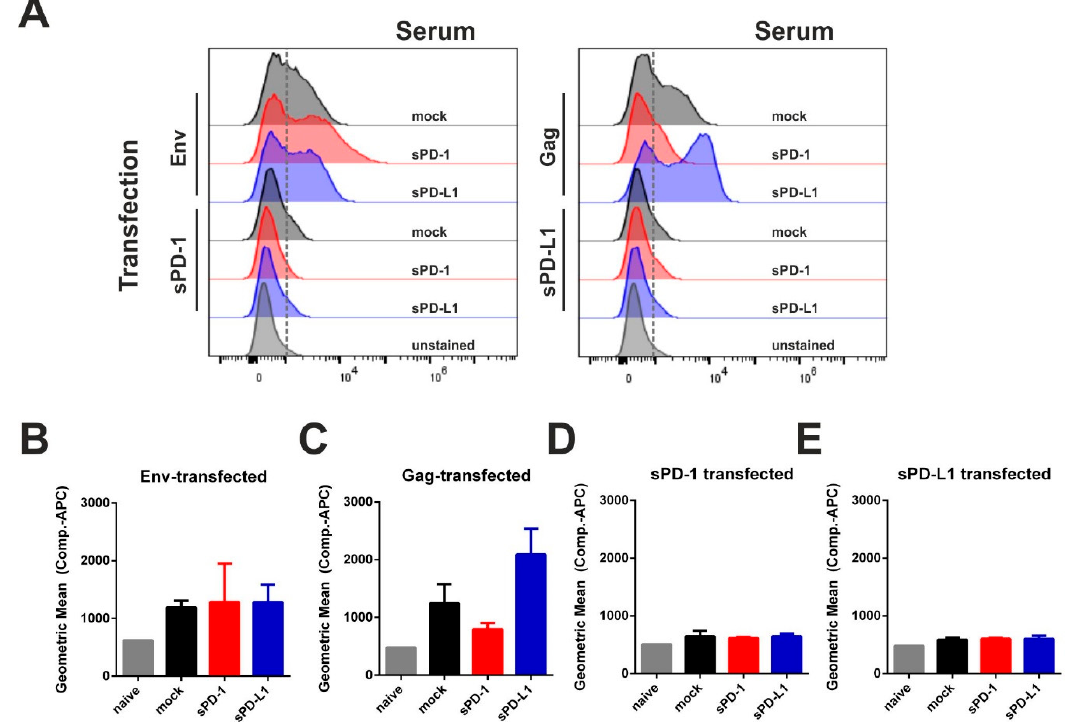
Figure 5. Soluble PD-1 and PD-L1 ectodomain co-expression is not inducing an autologous antibody response. 293T cells were transfected with plasmids encoding for Env, Gag, sPD-1, or sPD-L1. Twenty-four hours after transfection, cells were treated with Brefeldin A for 6 h in order to inhibit protein transport. Subsequently, cells were fixed, permeabilized, and incubated with sera from mice immunized with Env- and Gag-DNA either with empty vector (mock) or with corresponding checkpoint ectodomain DNA (sPD-1, sPD-L1). Murine antibodies were detected using an APC-conjugated anti-mouse IgG1 antibody. Shown are the histograms of transfected cells ( A ) as well as the Geometric Mean Fluorescence Intensity of Env- ( B ), Gag- ( C ), sPD-1 ( D ), and sPD-L1 transfected cells ( E ) after incubation with immunized mouse sera and the respective secondary antibody. ( A ) Data are representative of three independent experiments. ( B – E ) Data represent the mean with SEM of one out of three representative experiments with three sera samples from each group.